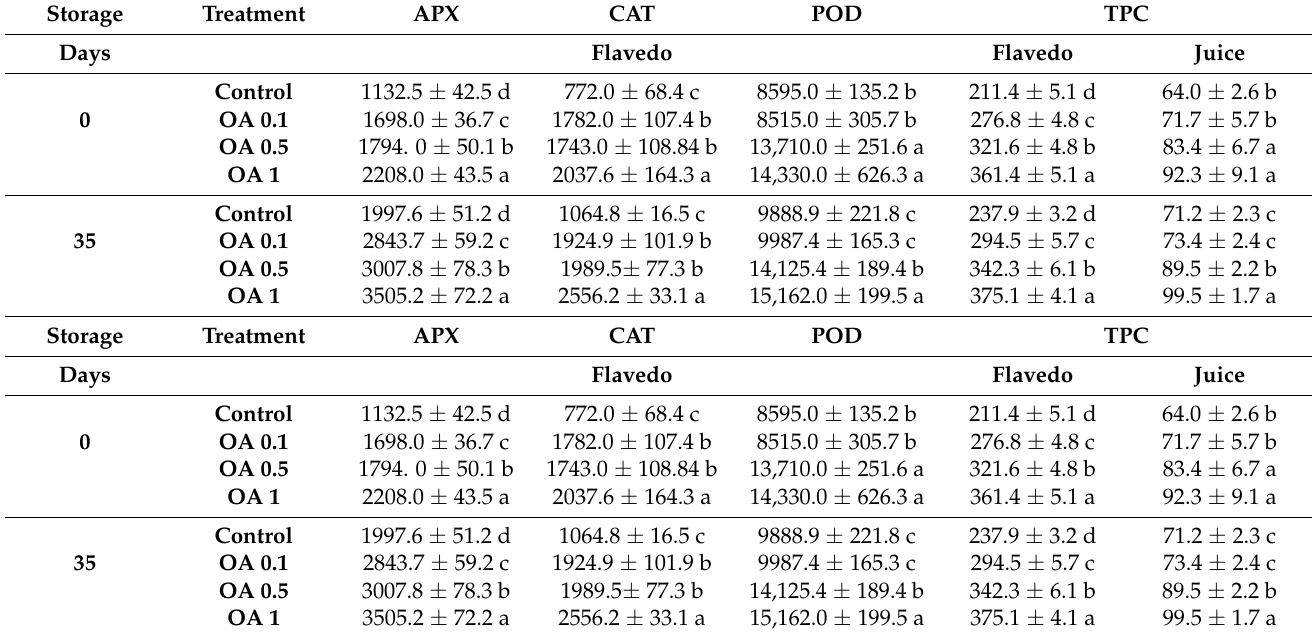
Table 2. The activity of the antioxidant enzymes (U min − 1 g − 1 ), ascorbate peroxidase (APX), catalase (CAT), and peroxidase (POD) in the flavedo and total phenolic content (mg 100 g − 1 ) in the flavedo and juice from the control and oxalic acid (OA) treated trees at harvest (day 0) and after 35 days of storage at 10 ◦ C in the 2019 experiment. Data are the mean ± SE of the four replicates. Different lowercase letters in the same column indicate significant differences ( p <0.05) among treatments for each sampling